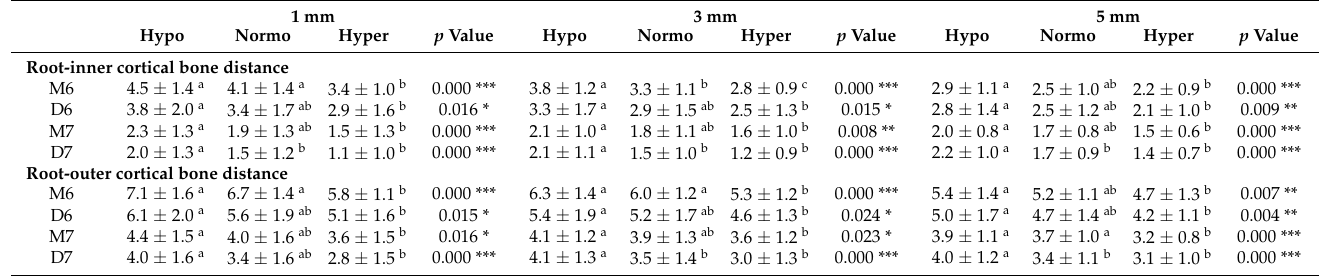
Table 3. Mean distance ( ± standard deviation) between the mandibular molar roots and lingual cortical bone according to the vertical facial patterns.